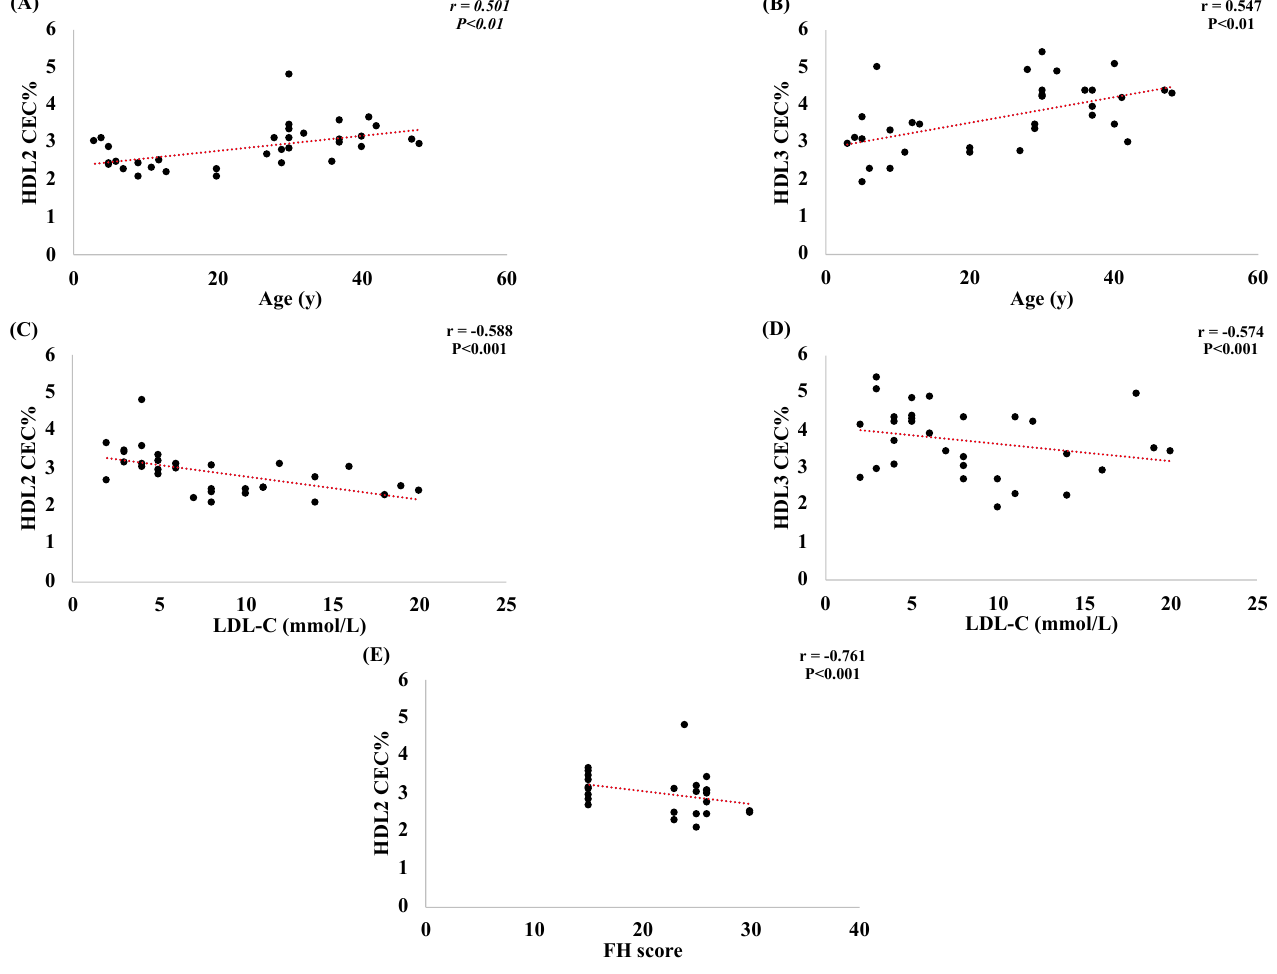
Figure 2. Correlations between the CEC% of HDL subfractions and age (( A ) and ( B )), LDL-C (( C ) and ( D )), and FH score ( E ) in all FH patients, combined. Table 4. Multinomial logistic regression for CEC in relation to FH status (Reference: healthy